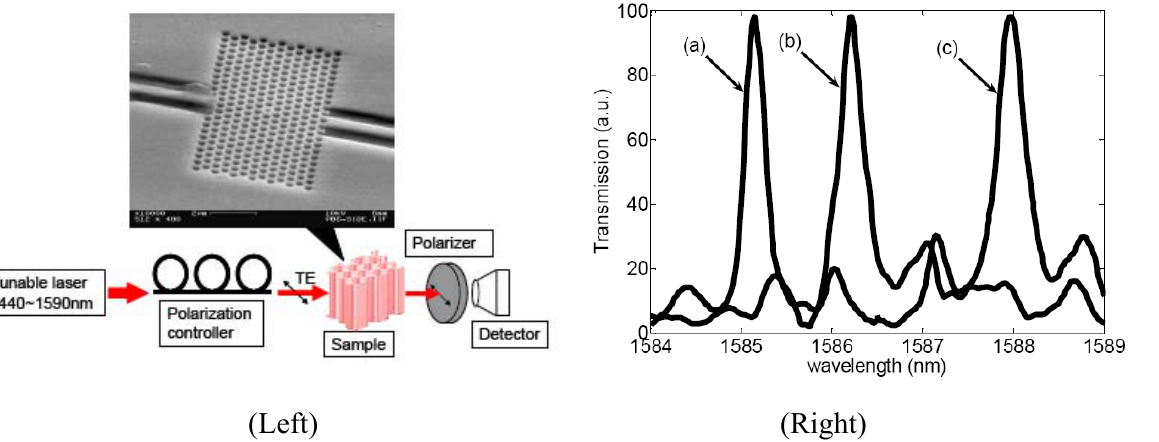
Figure 10. (Left) Scanning electron microscopy photograph of a typical photonic crystal and schematic of the experimental setup. A tunable laser (1,440 nm to 1,590 nm) is used as the source. Light is coupled in and out of the PhC using tapered ridge waveguides. A polarization controller is used to maximize the TE mode signal, and an InGaAs detector is used to measure the transmission signal. (Right) Normalized transmission spectra of the PhC microcavity. Curve (a) indicates the initial spectrum resonance after oxidation and silanization, curve (b) is measured after glutaraldehyde attaches to the pore walls, and curve (c) is obtained after infiltration of BSA molecules. Reproduced from [45].